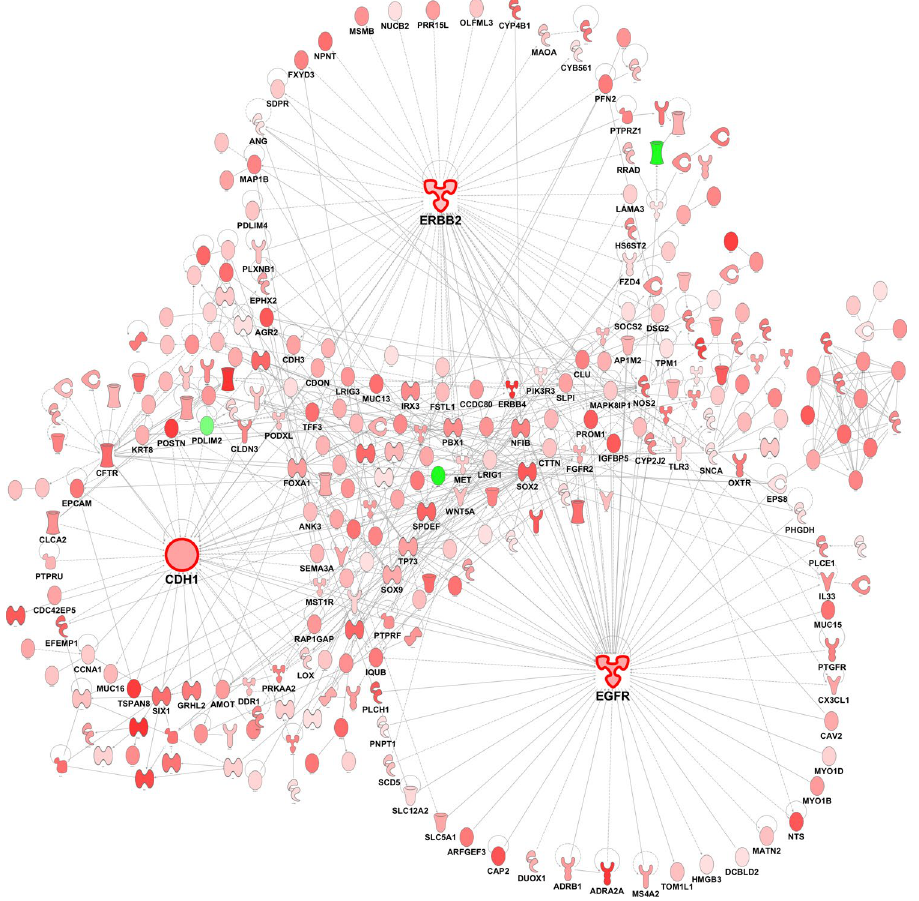
Figure 3. Differential gene network comparing HDM S wheezers versus HDM S nonwheezers. Differentially expressed genes were identified with an edgeR analysis. Gene expression patterns in sputum were compared between HDM S wheezers versus HDM S nonwheezers. The wiring diagram of the underlying gene network was reconstructed employing prior knowledge from the literature (Ingenuity Knowledge Base). Genes highlighted in red denote upregulation, whilst molecules in green indicate downregulation in HDM S wheezers.